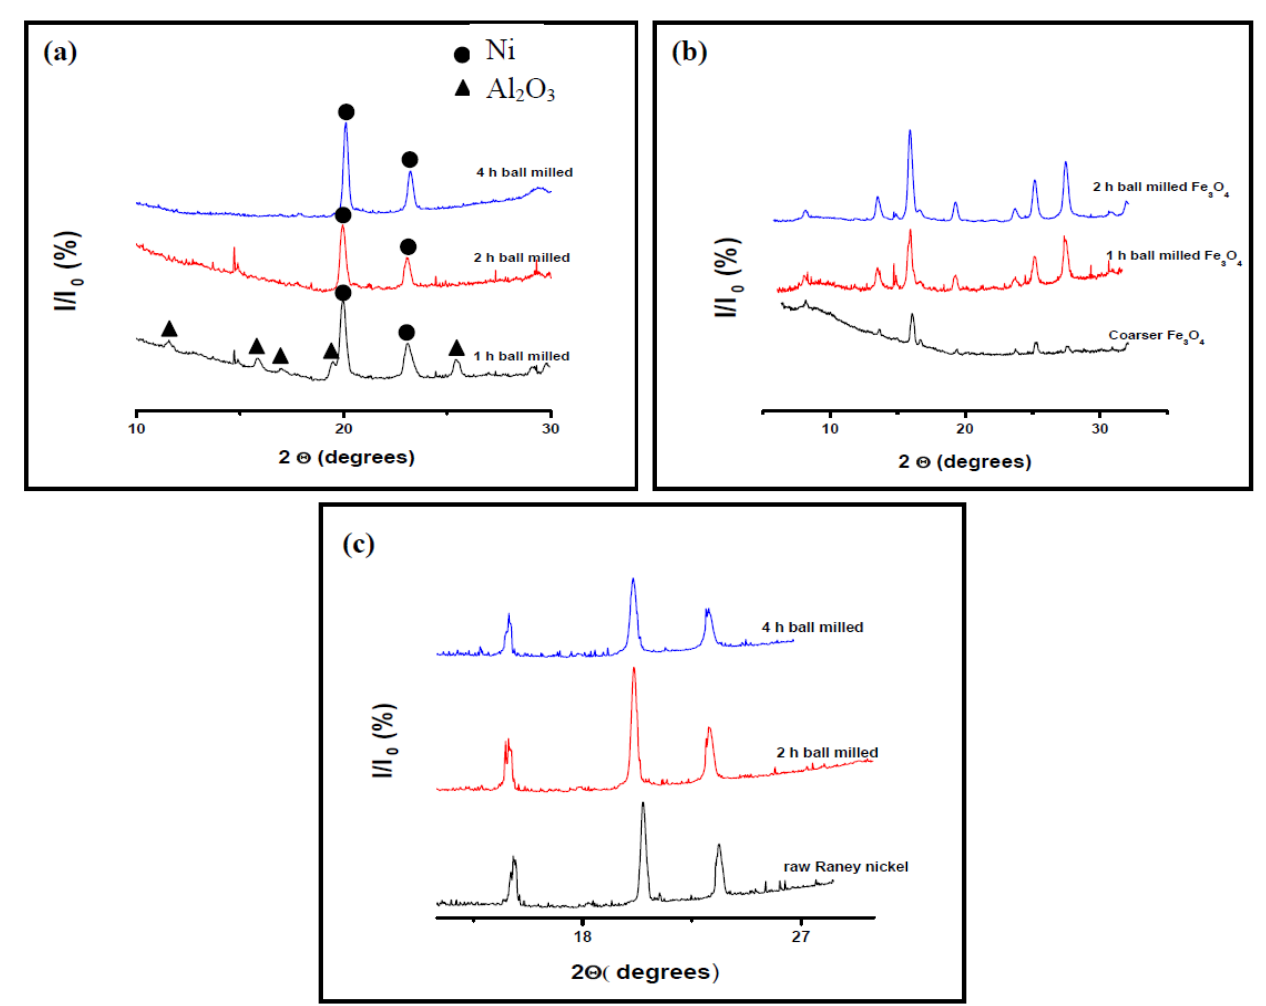
O : Ni ( b ) magnetite ( c ) Raney 2 3